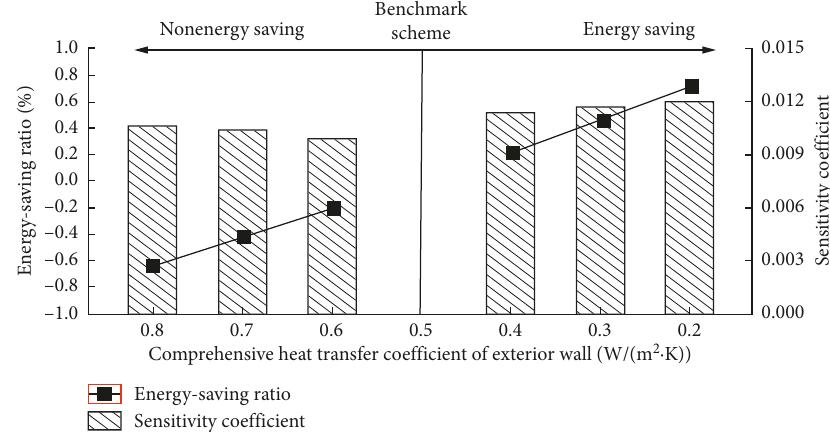
Figure 9: Energy-saving ratio and energy-saving sensitivity of the comprehensive heat transfer coefficient of the external Table 6: Design parameters of the building envelope energy-saving potential sequencing and recommended values. Design parameters of building envelope